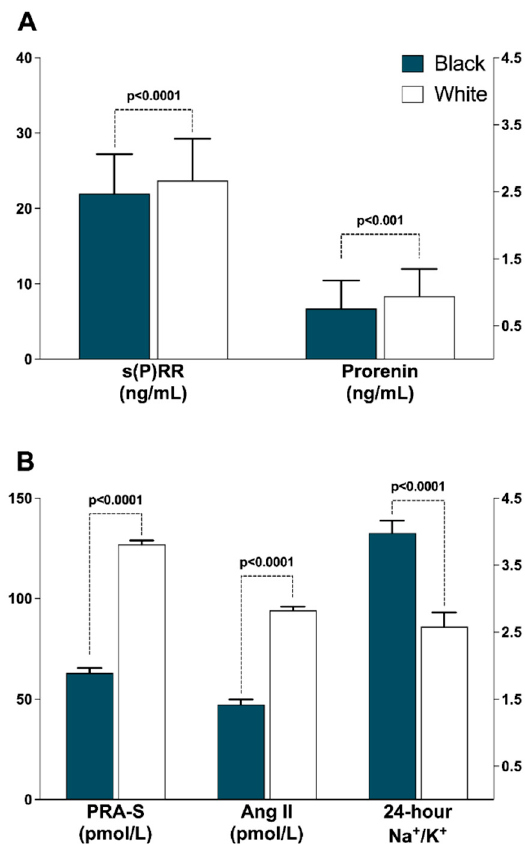
Figure 1. Ethnic comparisons of renin-angiotensin system profiles. ( A ) Soluble (pro)renin receptor and prorenin; ( B ) Plasma renin activity surrogate, Angiotensin II and Na + /K + . Abbreviations: s(P)RR, soluble (pro)renin receptor; PRA-S, angiotensin-based plasma renin activity, AngII, Angiotensin II. Analyses adjusted for sex, ethnicity and waist circumference in the total group (Table 3) revealed a statistically significant positive association between relative wall thickness and s(P)RR (r = 0.062; p = 0.036). In the participants as stratified by ethnicity, an additional adjustment was made for socioeconomic status score. In black participants, the positive association between SVi and s(P)RR persisted (r = 0.11; p = 0.008). In white participants, statistically significant partial-correlation coefficients were observed between relative wall thickness and LV ejection fraction and s(P)RR (all p ≤ 0.024), with an additional negative linear association observed between SVi and s(P)RR (r = − 0.142; p = 0.001). In multivariable-adjusted linear regression analysis adjusted for ethnicity, sex, waist circumference, socioeconomic score and other covariates (Table 4), some of the associations between s(P)RR and measures of LV structure and function became attenuated and lost statistical significance, whereas new associations became evident. In ethnicity-pooled anal- ysis, none of the associations remained statistically significant; however, a borderline-linear positive association was observed between s(P)RR and relative wall thickness ( β = 0.073; p = 0.056). In white participants, there was a positive linear association between rela- tive wall thickness and s(P)RR ( β = 0.141; p = 0.005) and negative associations between LV ejection fraction ( β = − 0.123; p = 0.016) and SVi ( β = − 0.144; p = 0.004) and s(P)RR. The adjusted R-squared for LV ejection fraction was <0.10, but statistically significant ( p < 0.001). Multivariable-adjusted linear regression models showing all covariates are shown in Tables S3–S5 and show s(P)RR as the main independent variables and the contri- bution of other covariates such as waist circumference, sex, ethnicity, glucose and Na/K to the